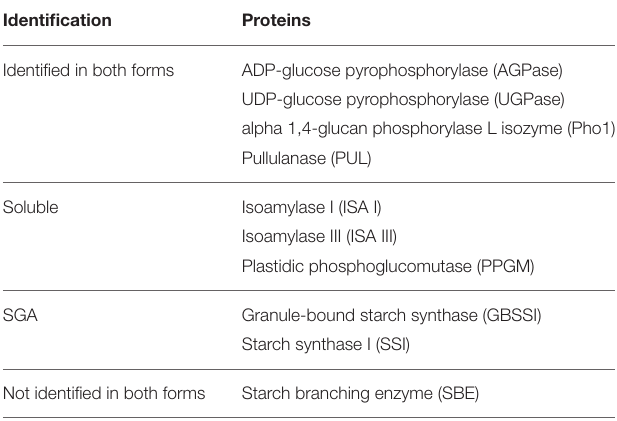
TABLE 1 | Comparison of differentially expressed starch granule-associated and soluble starch metabolism enzymes in developing rice